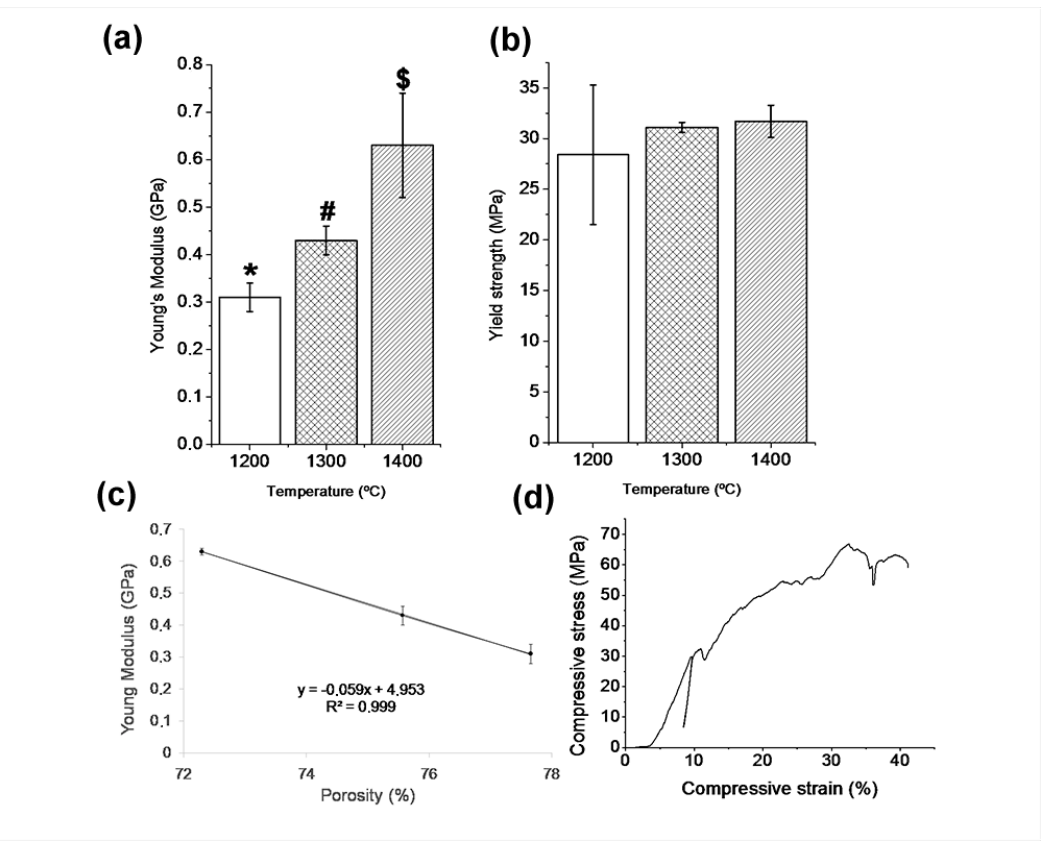
Figure 6. Mechanical properties of scaffolds at different sintering temperatures: ( a ) Young’s modulus; Samples with di ff erent symbols ( * , # , $ ) present statistically significant di ff erences ( p < 0.05); ( b ) Yield strength at 1200 ◦ C, 1300 ◦ C and 1400 ◦ C (di ff erent symbols indicate significant di ff erences ( p < 0.05) between conditions); ( c ) Porosity e ff ect on the Young’s modulus; ( d ) Representative stress–strain curve for Ti sca ff old sintered at 1400 ◦